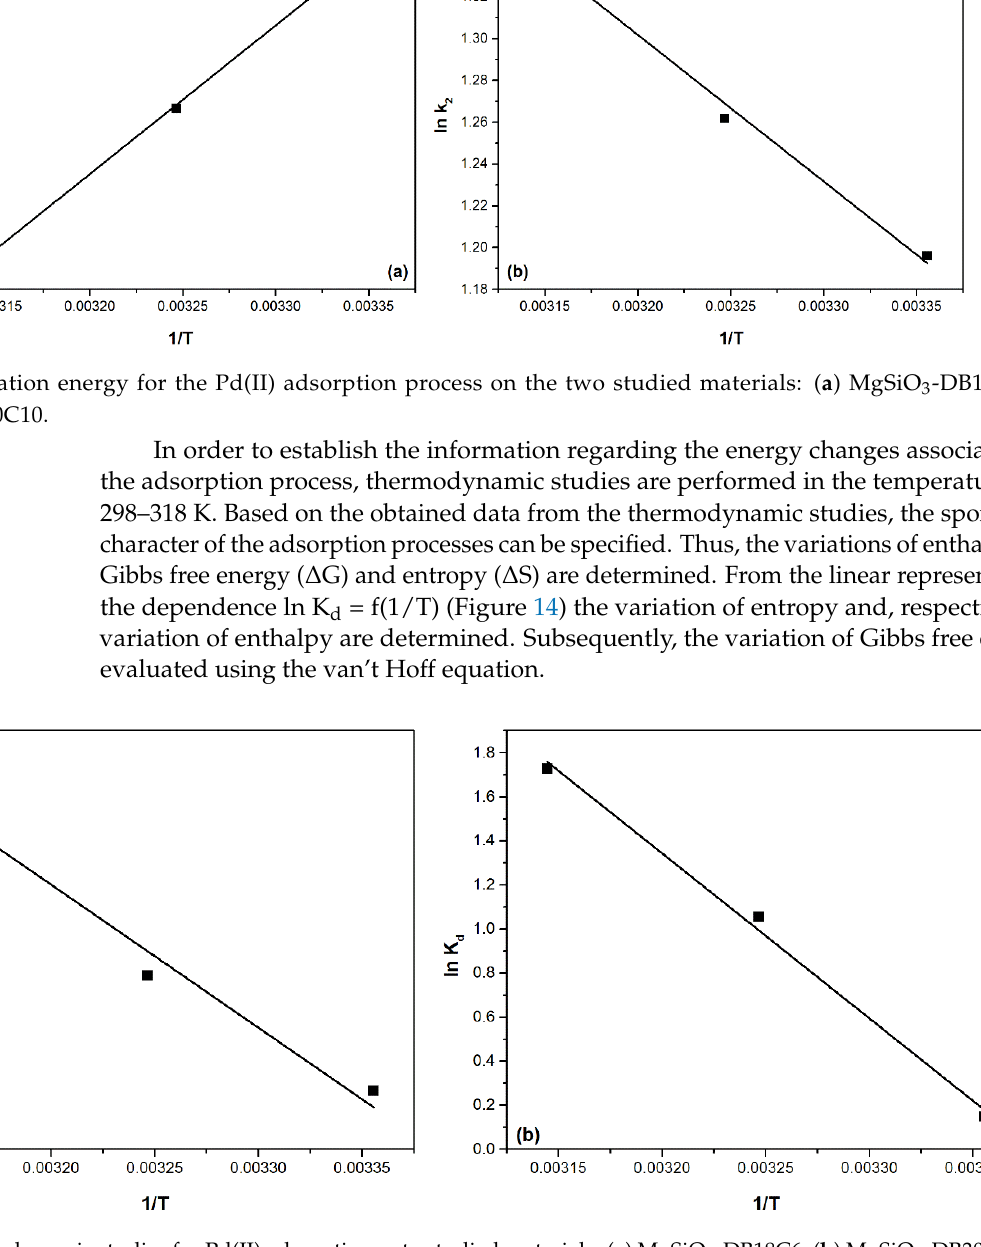
Table 5. Activation energy and correlation coefficient for the Pd(II) adsorption process.